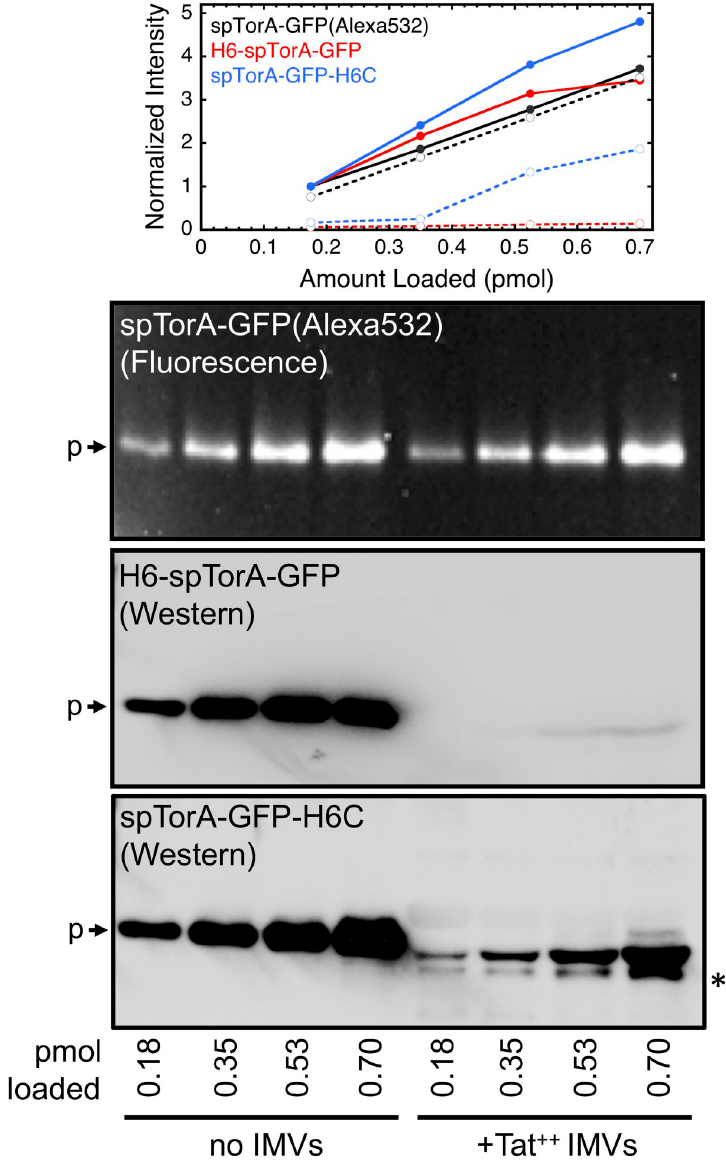
Fig 6. Western blots underestimate Tat precursor concentrations in the presence of Tat ++ IMVs. Different amounts of the indicated Tat precursors were electrophoresed in the absence or presence of Tat ++ IMVs ( A 280 = 5). In the graph at the top, the intensity dataset for each gel is normalized to the intensity for the 0.18 pmol load in the absence of IMVs: solid curves , no IMVs; dashed curves , +IMVs. The amount of spTorA-GFP(Alexa532) detected by in- gel fluorescence in the absence or presence of Tat ++ IMVs is linear with the load, and similar under the two conditions. In contrast, Western blots of H6-spTorA-GFP and spTorA-GFP-H6C using anti-6xHis antibodies substantially underestimate the presence of these proteins when electrophoresed with Tat ++ IMVs. The starred ( � ) band indicates a partially cleaved protein product, which is not the mature-length protein.